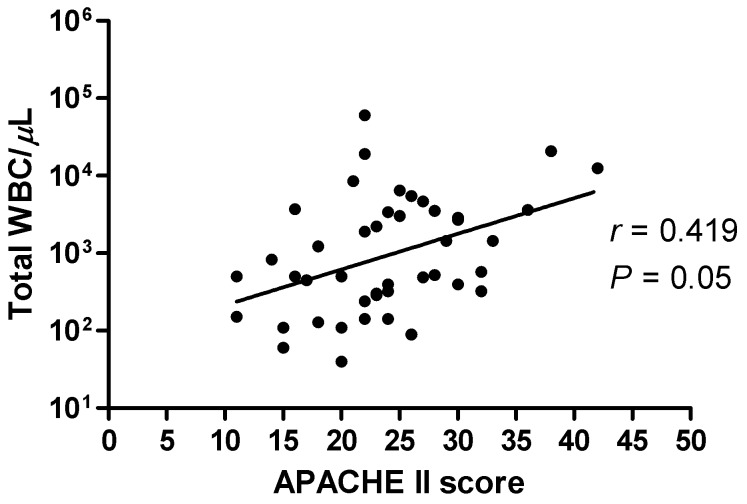
Correlation between bronchoalveolar lavage total white blood cell count and APACHE II score.